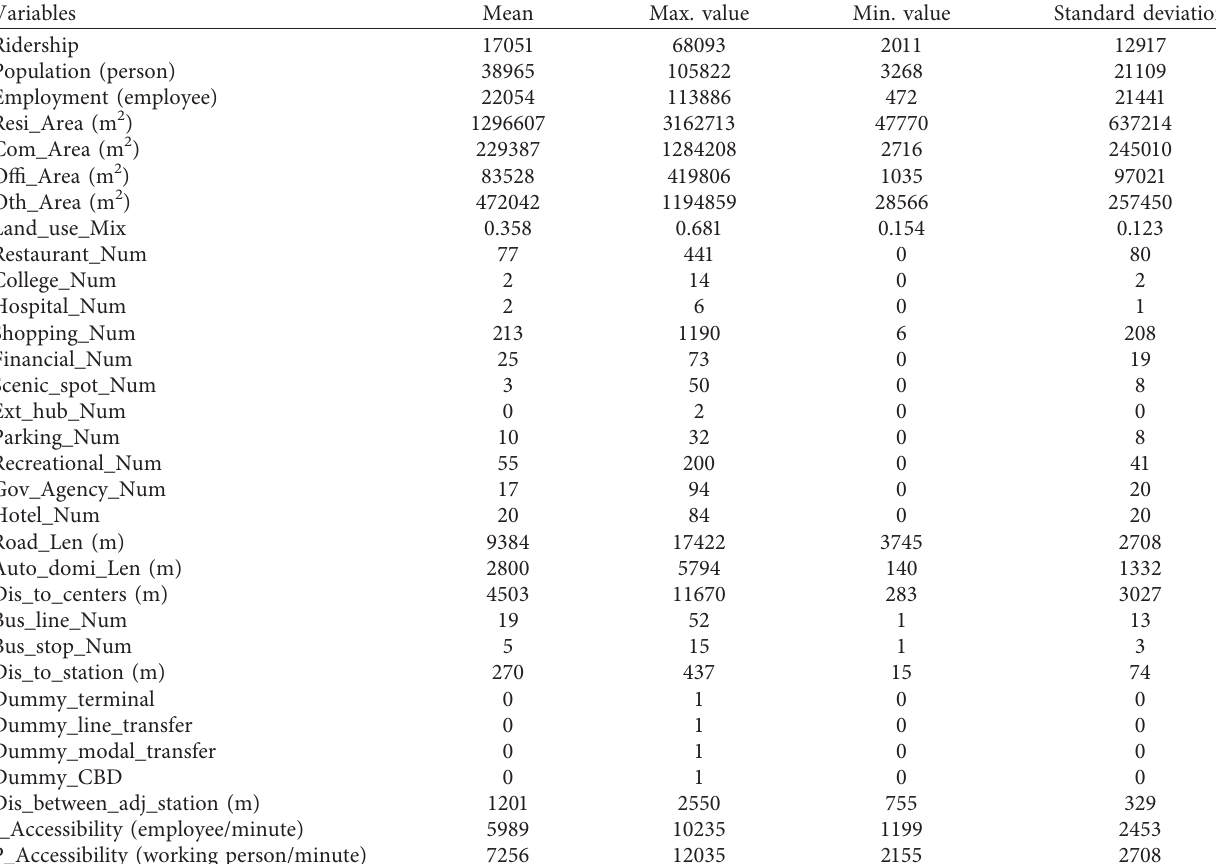
Table 3: Summary statistics for candidate variables.